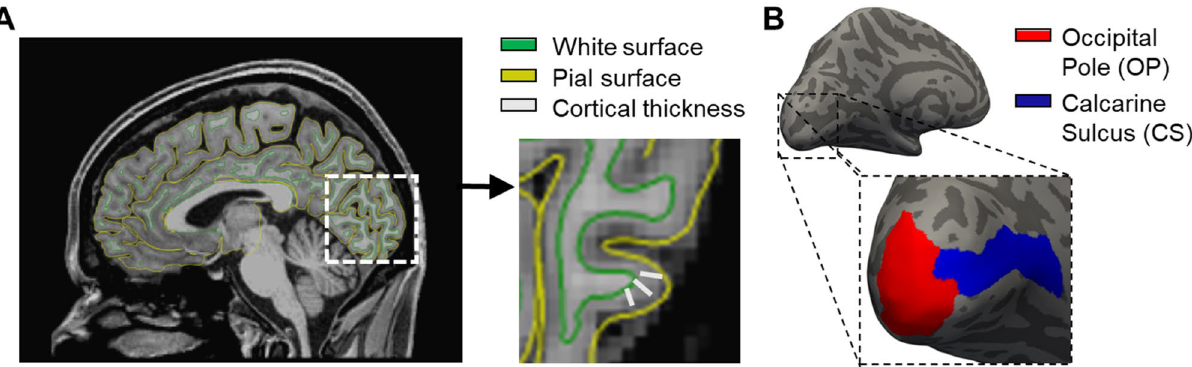
Figure 1. ( A ) Processed anatomical data in the sagittal view, zooming in on occipital regions. Cortical thickness (grey lines) is calculated by taking the shortest distance (mm) between the white matter surface (green) and the grey matter/pial surface (yellow). ( B ) Our regions of interest (ROIs) shown on the inflated cortical surface: Occipital pole (red) and calcarine sulcus (blue) taken from FreeSurfer’s Destrieux